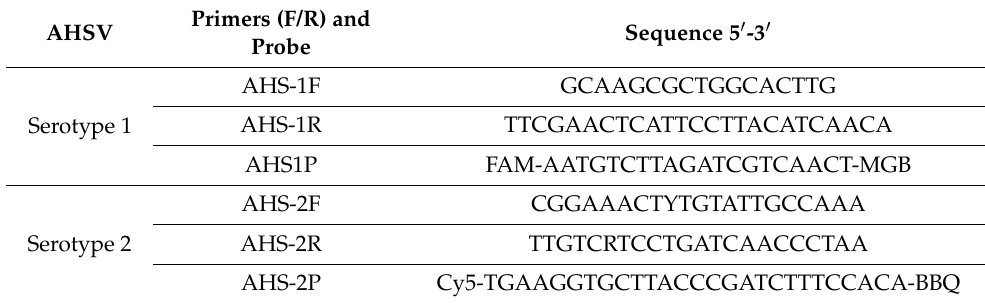
Table 2. Serotype-specific rRT-PCR primers and probes targeting VP2 AHSV genes specific for each